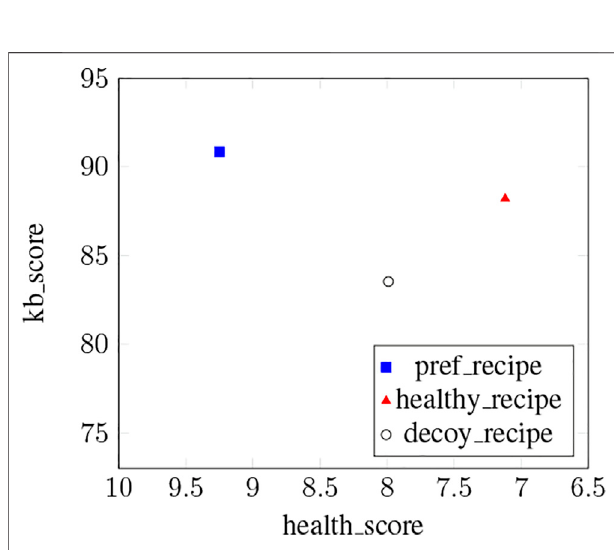
FIGURE 6 | Average kb _ score and health _ score for the three types of recipes recommended by our system.